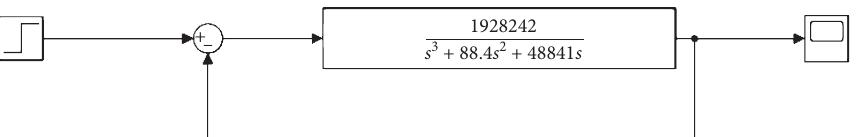
Figure 9: Simulation diagram of hydraulic synchronous system transfer function.